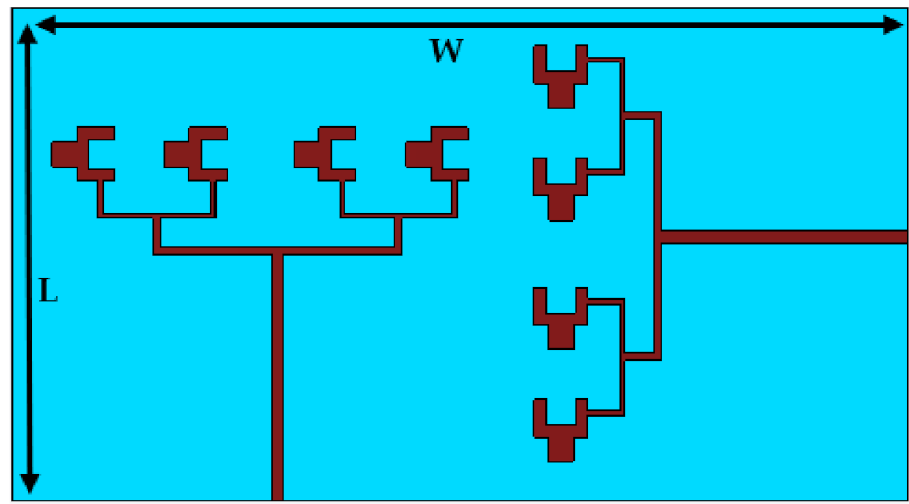
Figure 5. Corporate feed array MIMO configuration.